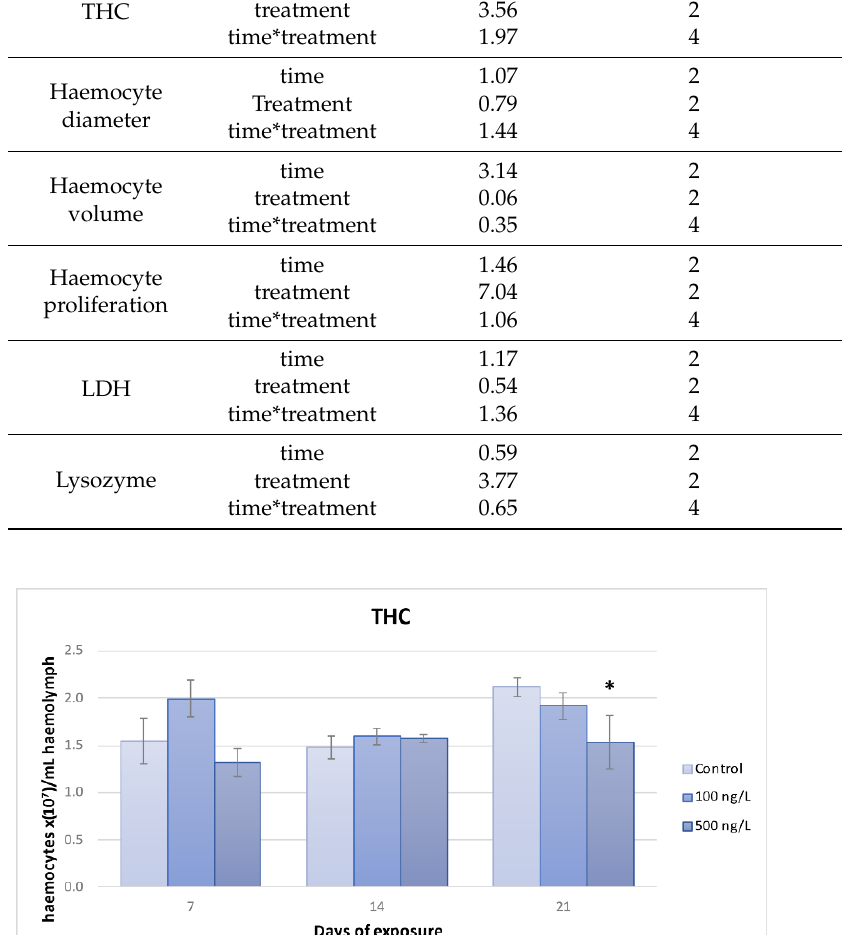
Figure 2. Haemocyte proliferation in Ruditapes philippinarum after exposure to 100 ng/L and 500 ng/L of HHCB for 7, 14 and 21 days. The results are expressed as OD 450 and are reported as means ± standard error; n = 6. Asterisks indicate significant differences compared to controls at the same time of exposure: * p < 0.05, ** p < 0.01.